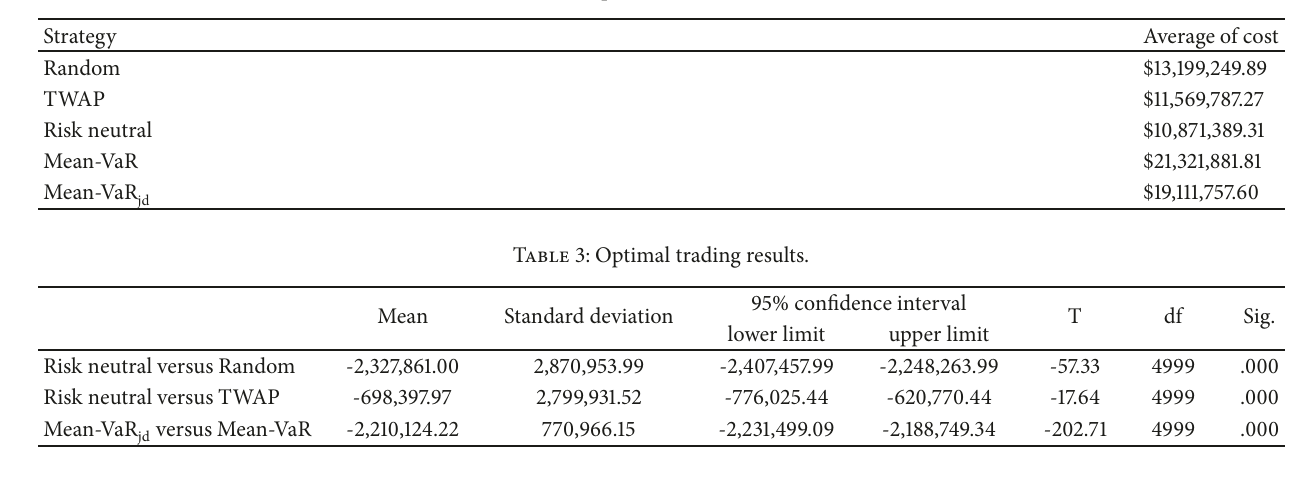
Table 2: Optimal execution results.